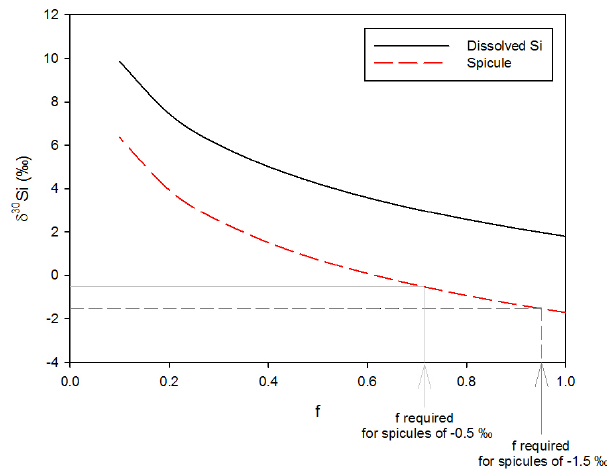
Figure 7. Sponge fractionation model for internal Si in an iso- topically closed system. We assume a variable fractionation fac- tor (cid:15) (cid:48) that approximates (cid:49)δ 30 Si from the core top spicule cali- bration curve of Hendry and Robinson (2012): (cid:49)δ 30 Si = − 6 . 54 + ( 270 /( 53 +[ Si ( OH ) 4 ] )) . The internal dissolved Si will fraction- ate according to δ 30 Si ( OH ) 4internal = δ 30 Si ( OH ) 4initial + (cid:15) (cid:48) · ln (f ) . Where f is the fraction of dissolved Si left available internally. The δ 30 Si of the spicules that form from this silicon depleted fluid is then given by δ 30 Si = δ 30 Si ( OH ) 4internal + (cid:15) (cid:48)